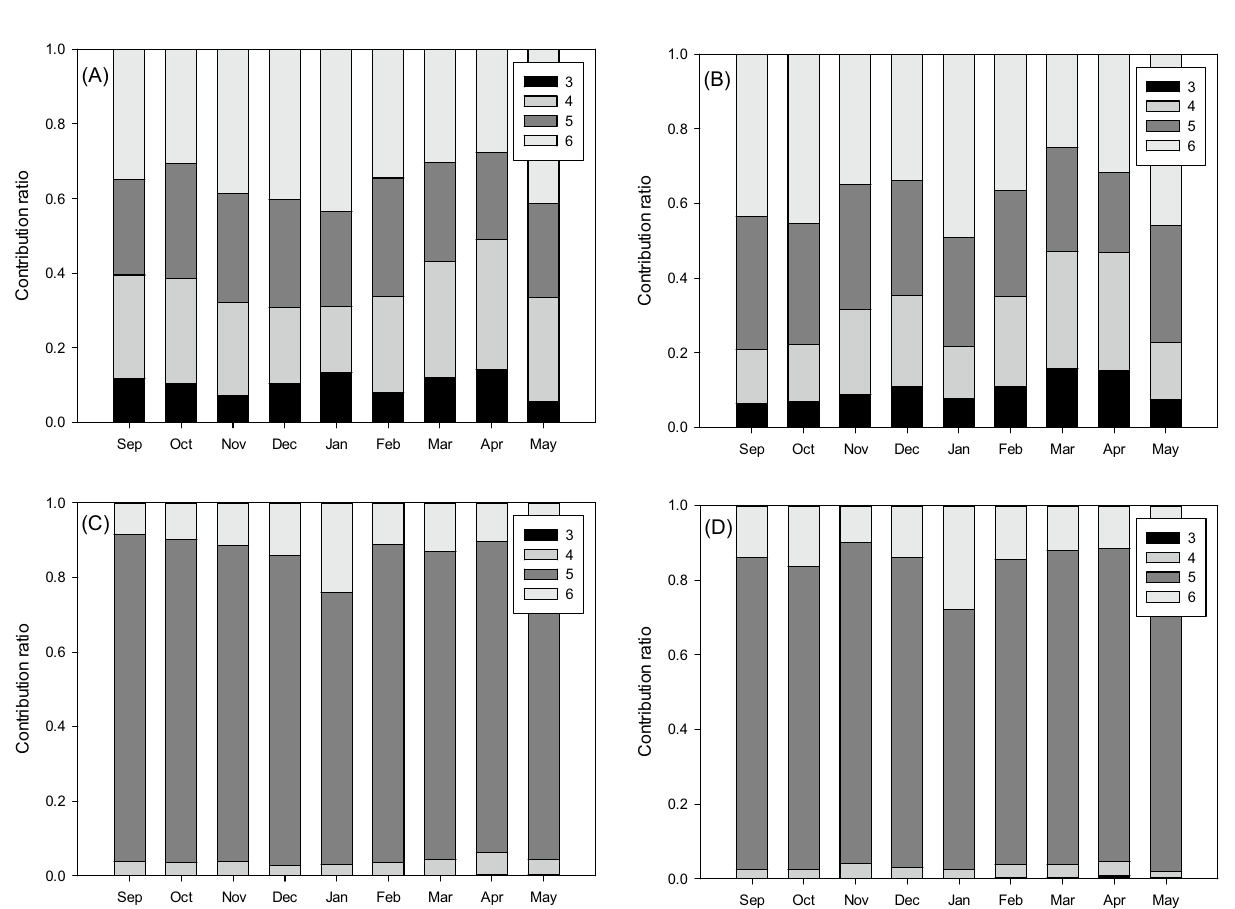
Figure 6. Contributions of PAHs with different ring numbers to the PM 2.5 -associated PAH concentrations during ( A ) daytime and ( B ) nighttime and PM 2.5 -associated BaP eq concentrations during ( C ) daytime and ( D ) nighttime in different